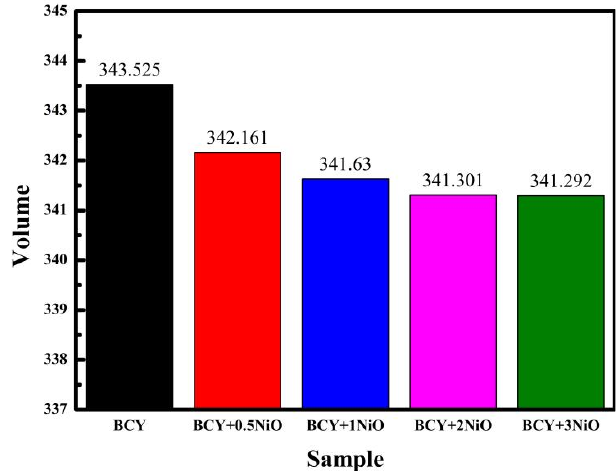
Figure 3. Column diagram of the lattice volume of BCY–NiO composites.